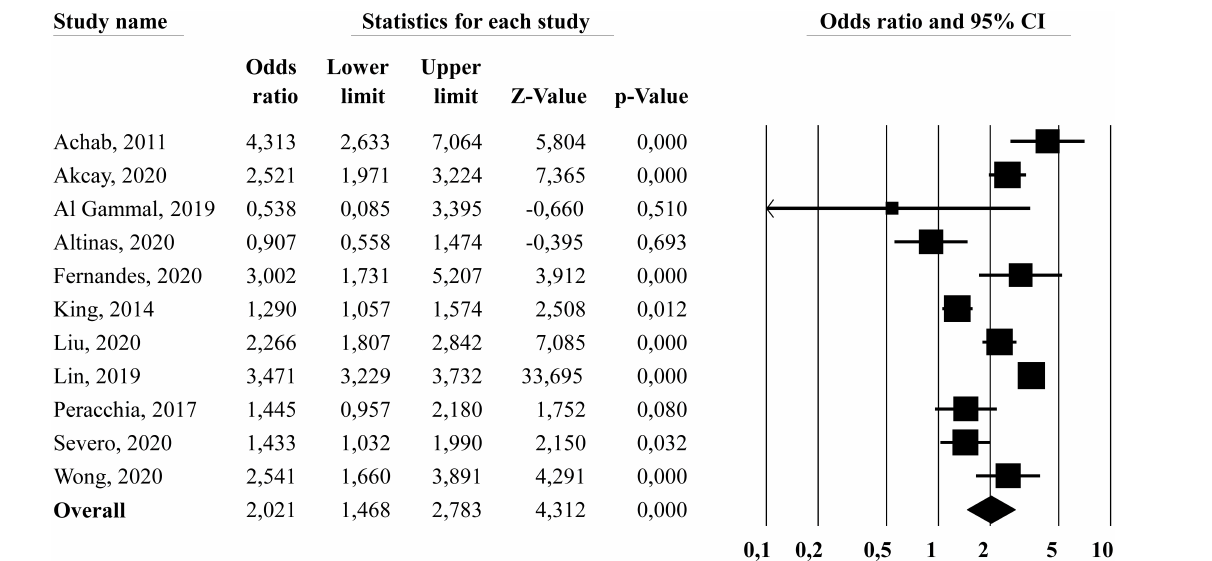
FIGURE 3 | Forest plot showing the association (odds ratio) between problematic gaming and sleep quality.